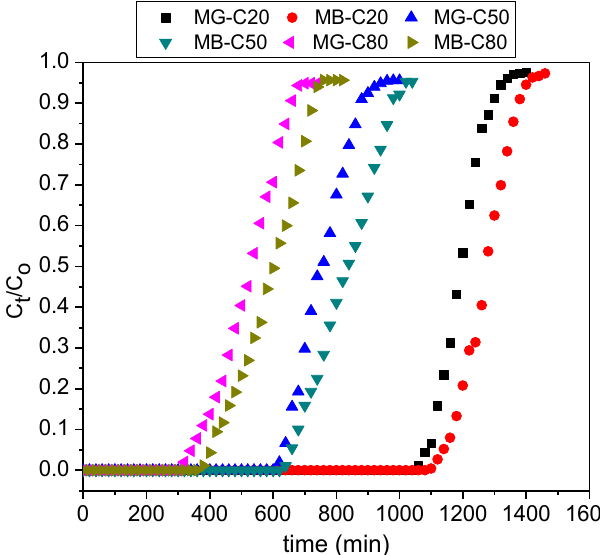
Figure 7. Breakthrough curves for adsorption of MG and MB in the binary system at varying initial concentrations (pH: 9; Z : 6 cm; Q : 3.0 mL/min).